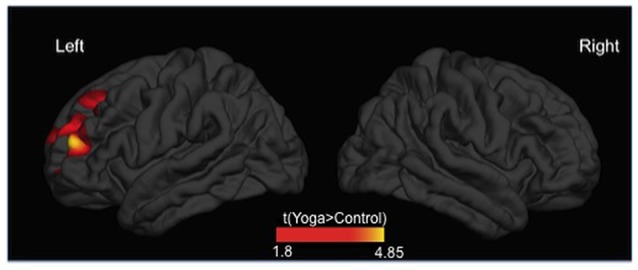
Differences in cortical thickness (CT) between yoginis and controls (P < 0.05, cluster corrected). Yoga practitioners showed greater CT in a cluster in the left prefrontal cortex (RTF-based, cluster-corrected, p < 0.05).